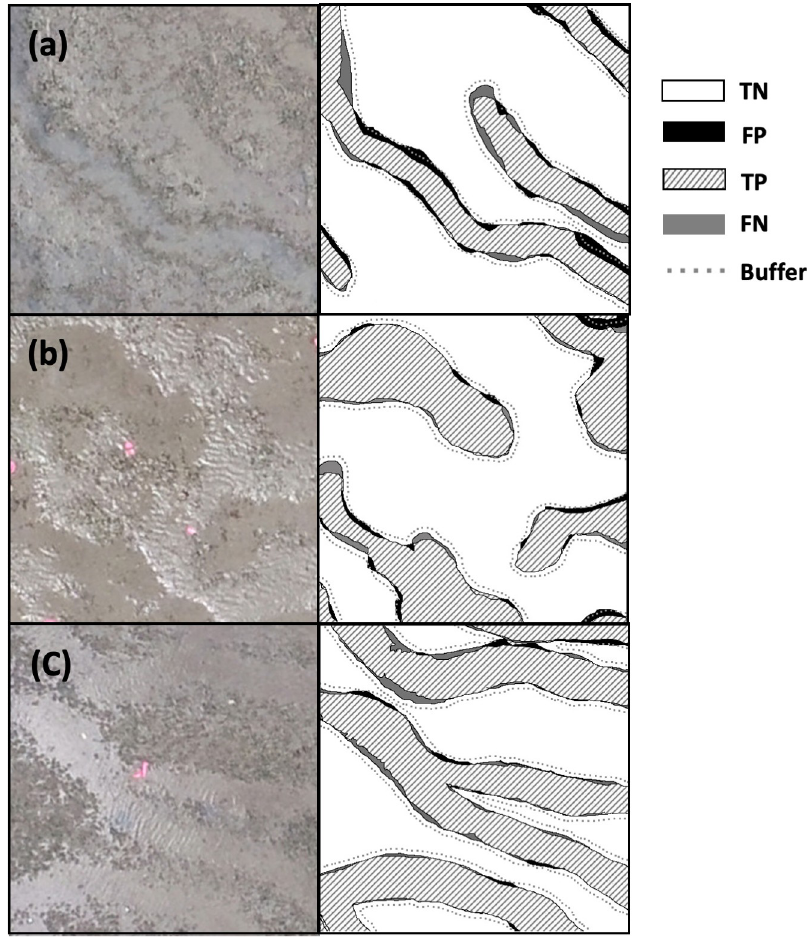
Fig 11. Examples of input (left inset) and extraction (right inset, true negatives TN are in the white area, false positives FP in the black area, true positives TP in the striped area, and false negatives FN in the gray area). The gray dotted line shows the buffer boundaries for the 7 pixels (0.47 cm/pixel) used in this study.